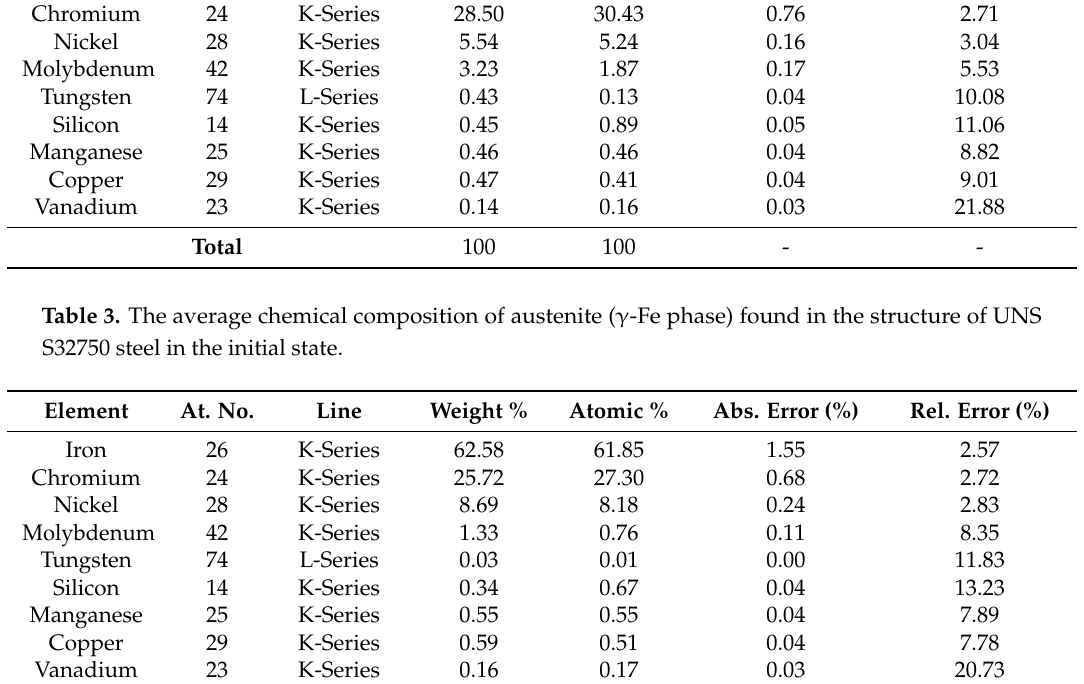
Table 2. The average chemical composition of ferrite ( δ -Fe phase) found in the structure of the UNS S32750 steel in the initial state. Element At. No. Line Weight % Atomic % Abs. Error (%)